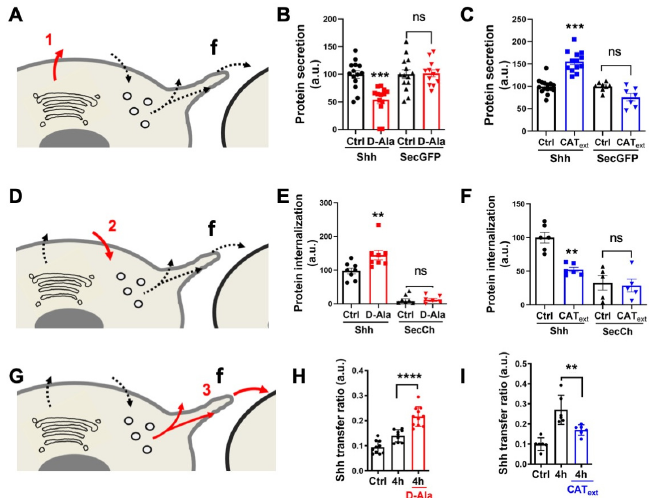
Figure 3. H 2 O 2 affects Shh secretion, endocytosis, and delivery in HeLa cells. ( A , D , G )